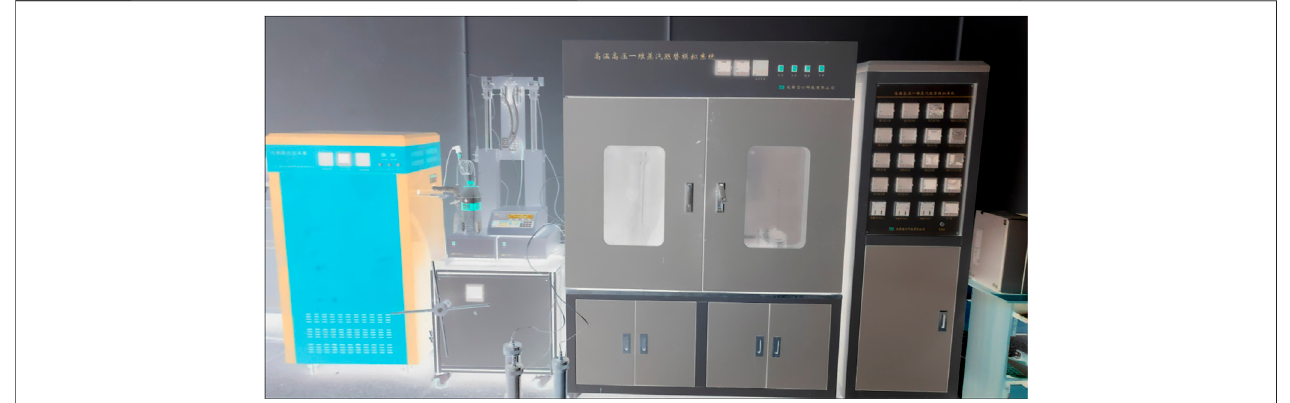
FIGURE 2 | High-temperature and high-pressure one-dimensional steam displacement simulation system of MG 236.